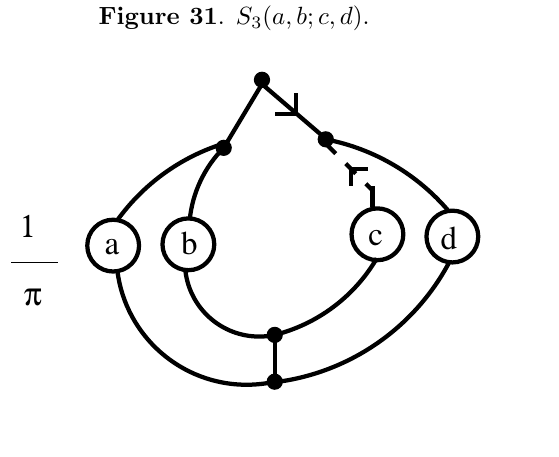
Figure 32 . S 4 ( a; b ; c; d